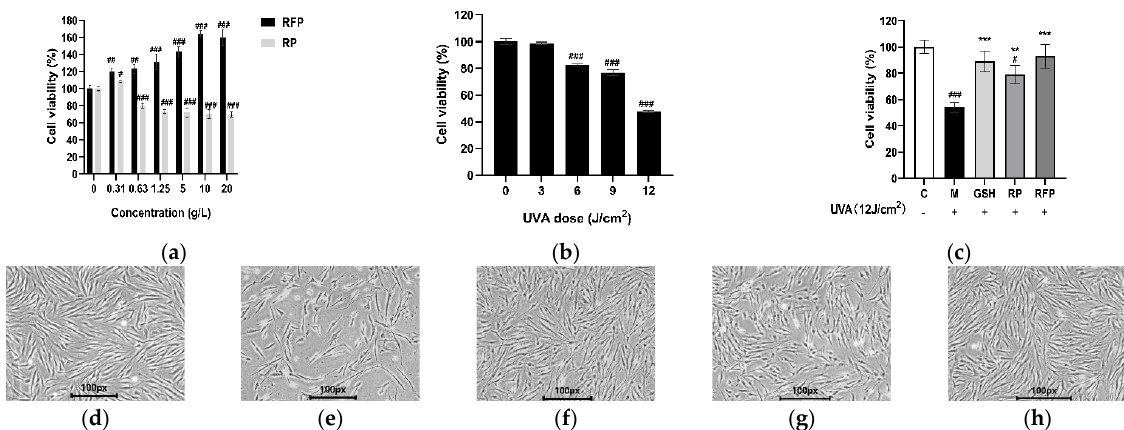
Figure 3. Effects of UVA, RFP, and RP on survival rate and morphology of HSF: ( a ) effects of RP and RFP on proliferation of HSF cells; ( b ) effects of different doses of UVA on survival rate of HSF cells; ( c ) cell survival rate of HSFs protected by samples; ( d ) control group; ( e ) model group; ( f ) positive group; ( g ) RP group; and ( h ) RFP group. # p < 0.033, ## p < 0.002, ### p < 0.001 as compared to control group (C); ** p < 0.002, *** p < 0.001 as compared to damage model group (M). Values do not have a common mark (#, *) when p >